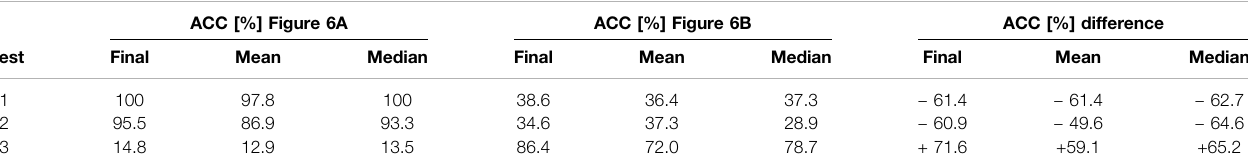
TABLE 4| Rankingperformanceaccuracyresults, takenfrom Figure6(A) forpartoneand Figure6(B) forparttwo.Themeanisanaverageof1 – 30testtrials.Themedian is calculated of trials 1 to 30, and the fi nal accuracy value is the achieved accuracy after 30 trials. Additionally, the accuracy difference between the two measurement parts is listed and is calculated by subtracting the respective accuracy value of part one (training with P1) from part two (training with